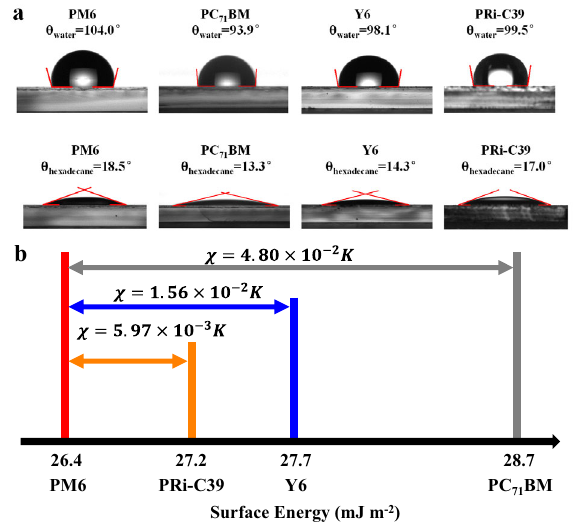
Fig. 5 Interactions between PM6 and the acceptors. a Droplet contact angle images of the pure fi lms of PM6, PC 71 BM, Y6, and PRi- C39. b Illustration of calculated surface energy γ and Flory-Huggins interaction parameter χ from the contact angle measurements.